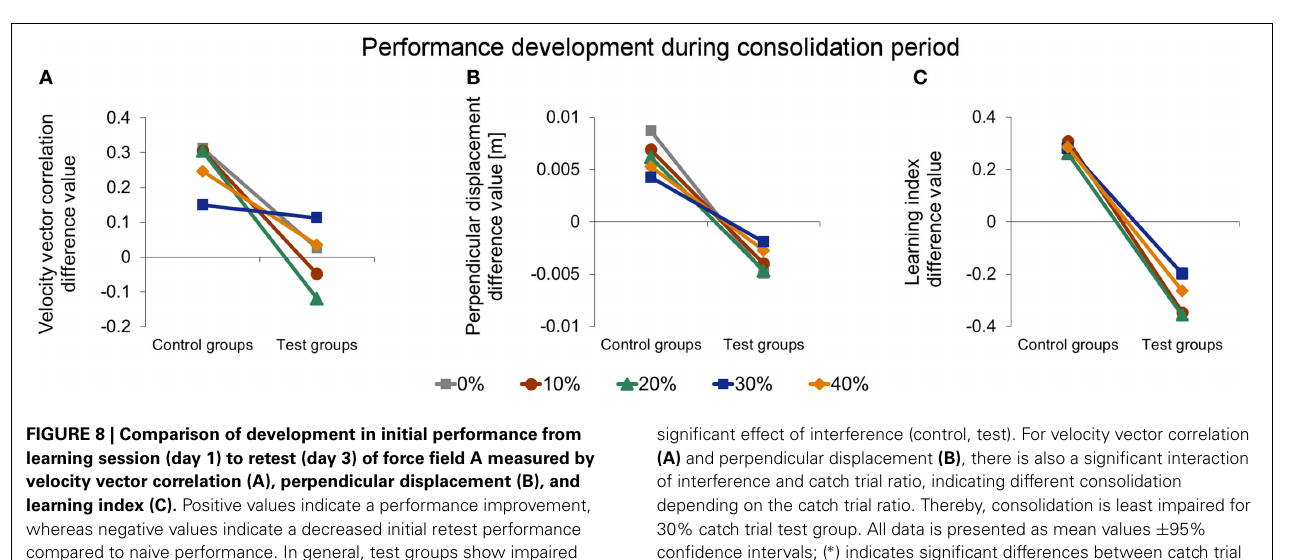
FIGURE 7 | Comparison of degree of adaptation between catch trial ratio groups using velocity vector correlation coefficient (A), perpendicular displacement (B), and learning index (C). All three performance measures indicate a significantly decreasing